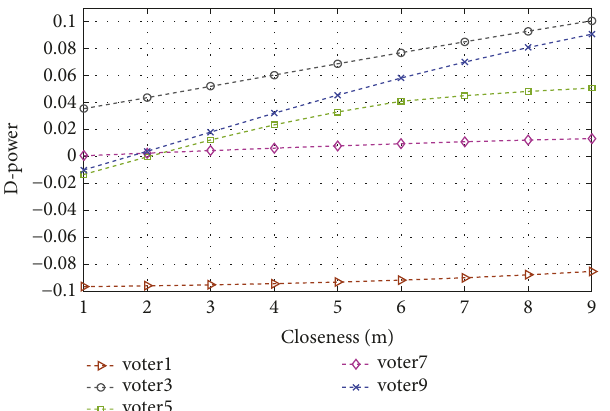
Figure 10: The influence of relationship closeness on the power index. Voters—within the social network shown in Figure 4—play a repeated voting game with the closeness among voter 𝑖 and his/her neighbor voters 𝑚 𝑖𝑗 = 𝑚 𝑖𝑘 (∀𝑗,𝑘 ∈ Γ 𝑖 ) increasing from 𝑚 𝑖𝑗 = 1 to 𝑚 = 9 while leaving other parameters or conditions unchanged. 𝑖𝑗 The changes in power indices increase ( 𝐷 - 𝑝𝑜𝑤𝑒𝑟(𝑖) = 𝑅 󸀠 (𝑖) − 𝐵 󸀠 (𝑖) ) with the voter’s closeness with neighbors